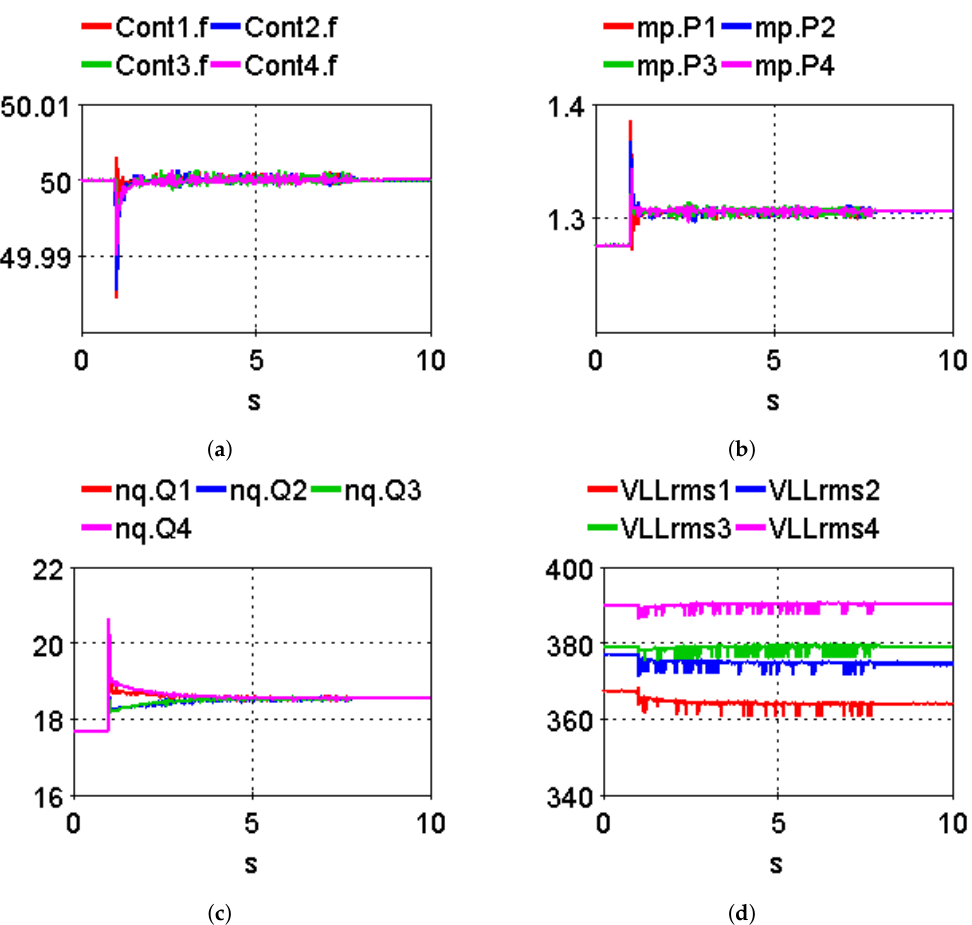
Figure 10. Real-time simulation results with constant DC sources on HYPERSIM with respect to time (s) with a 4 kW load (Ld1) increment at 1 s: ( a ) frequency restoration (frequency (Hz)); ( b ) proportional active power sharing; ( c ) proportional reactive power sharing; and ( d ) RMS values of V abc o